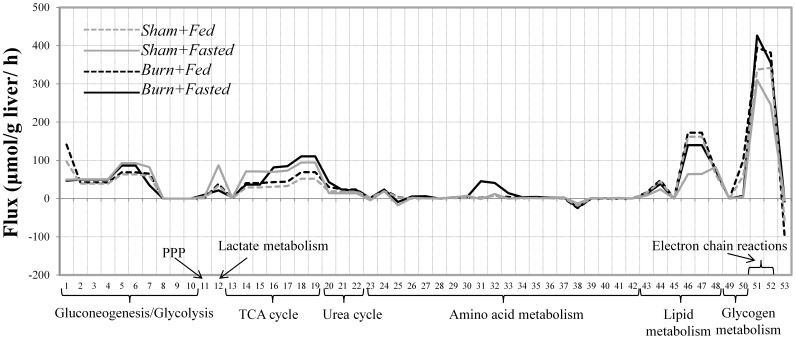
Calculated internal fluxes of perfused livers.An objective function maximizing the activity of shorter pathways was used to calculate the fluxes.